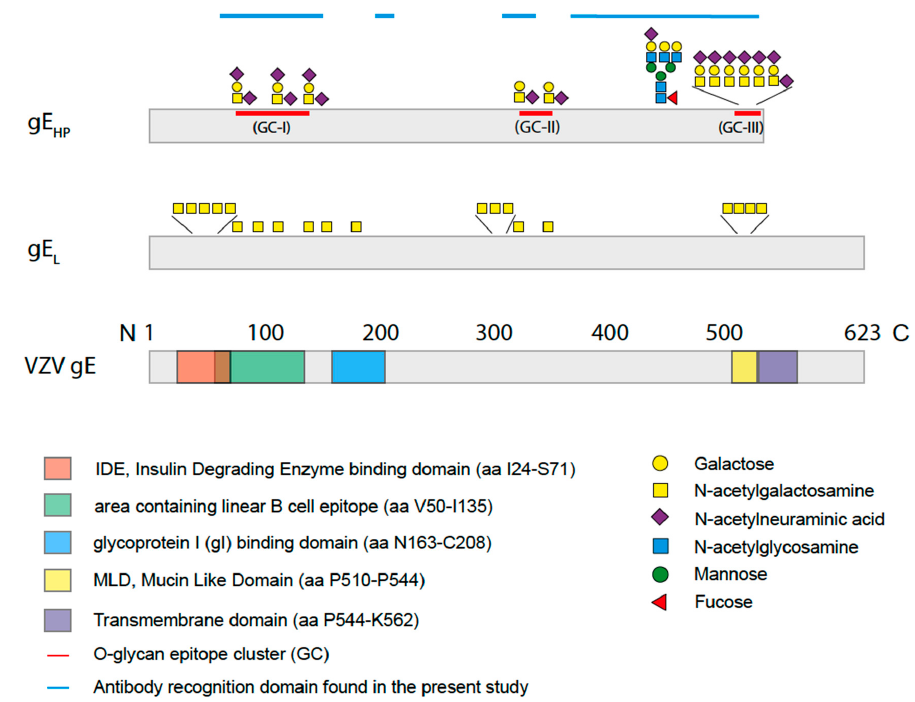
Figure 2. Schematic drawing of varicella zoster virus (VZV) gE, gE L , and gE HP with an outline of the glycan compositions and positions on the peptide sequence of gE HP as determined by mass spectrometry in the present study. Three O-linked glycan epitope clusters (GC) of sialylated core 1 O-linked glycans and one complex type N-linked glycan were found. Two O-linked glycans were situated within the linear B cell epitope (green) [29] while the largest cluster of O-linked glycans was found in the mucin-like domain (MLD) (yellow) close to the transmembrane domain (purple). For gE HP, neither the IDE domain (red) nor the gI-binding domain (blue) contained any glycans, while O-linked glycans were found in the corresponding domains of gE L [30].